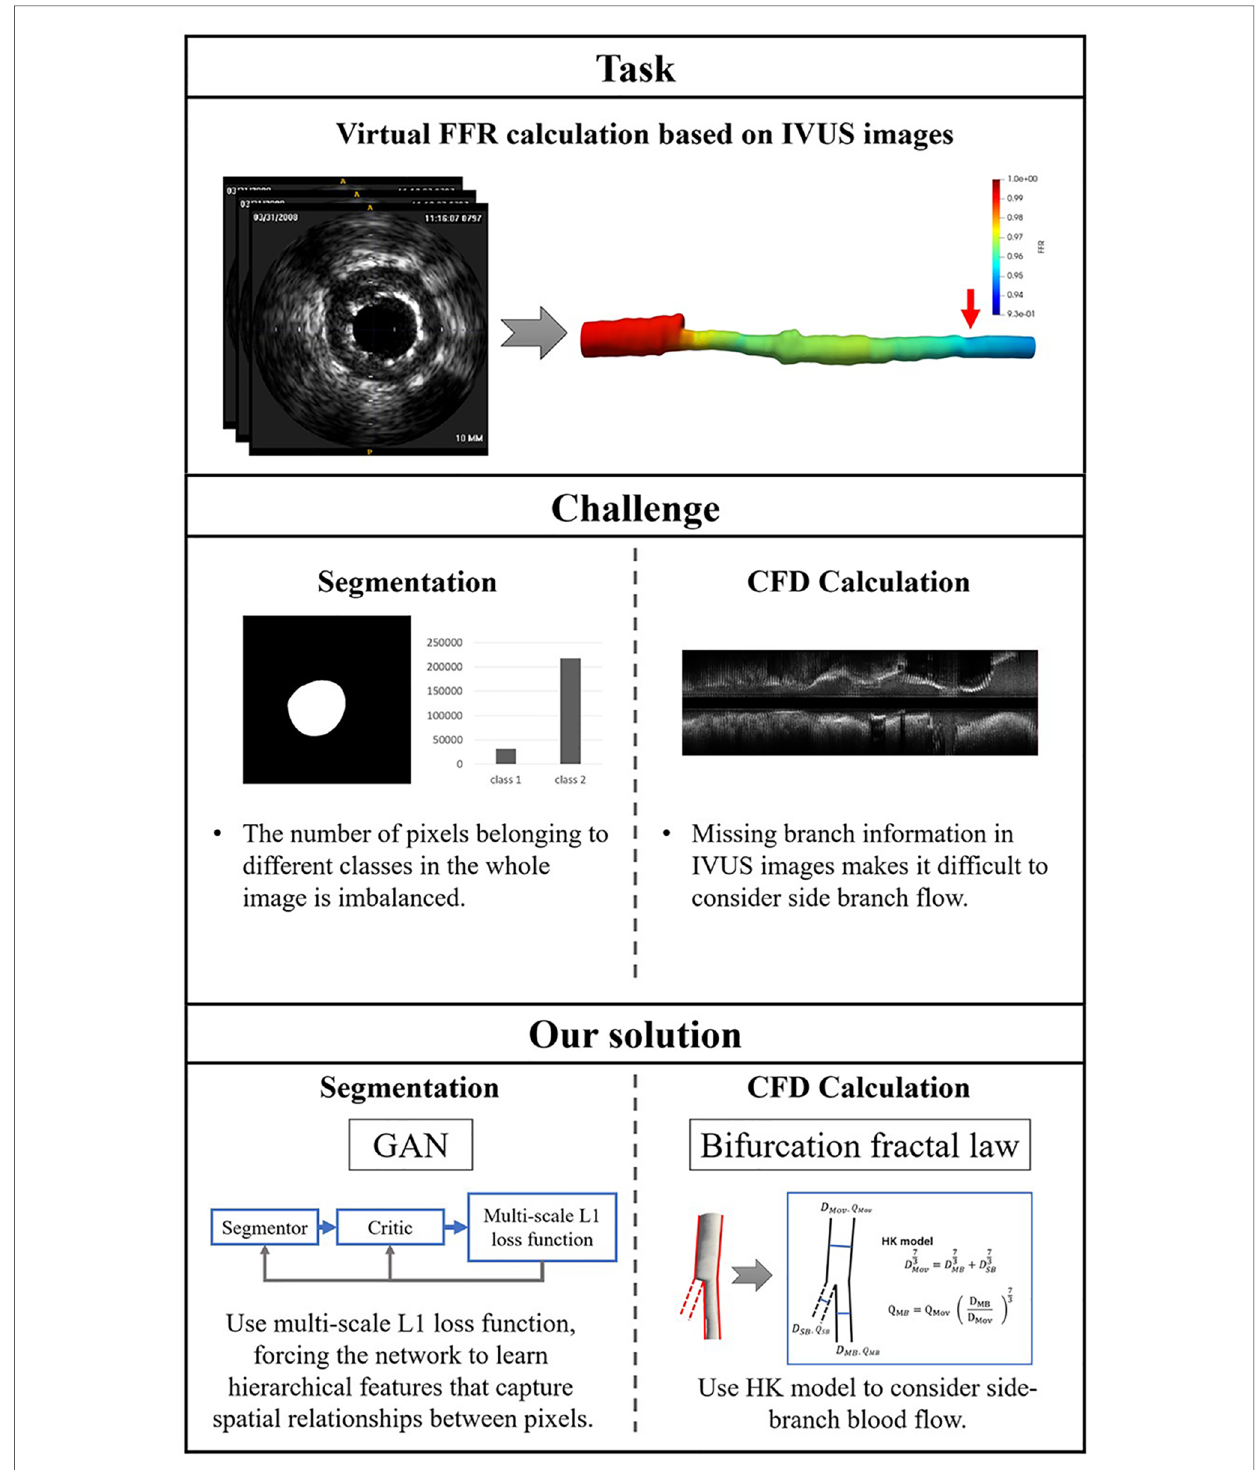
FIGURE 1 The challenges addressed by this study. The task of this study is to calculate virtual FFR value based on IVUS images. There are a few challenges in this task: First, the challenges of IVUS segmentation are learning contextual relationships between pixels and solving the problem of class imbalance. Second, missing branch information in IVUS images makes it dif fi cult to consider side branch blood fl ow. We proposed an IVUS-FFR analysis based on generative adversarial network and bifurcation fractal law to address these